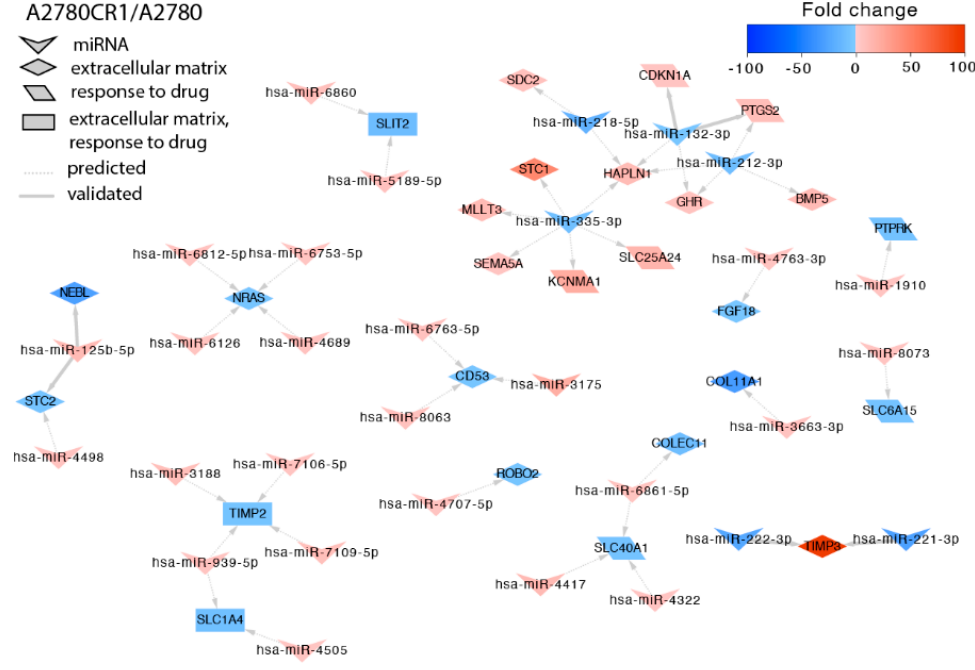
Figure 3. Regulation of selected target genes by miRNAs in the A2780CR1 cell